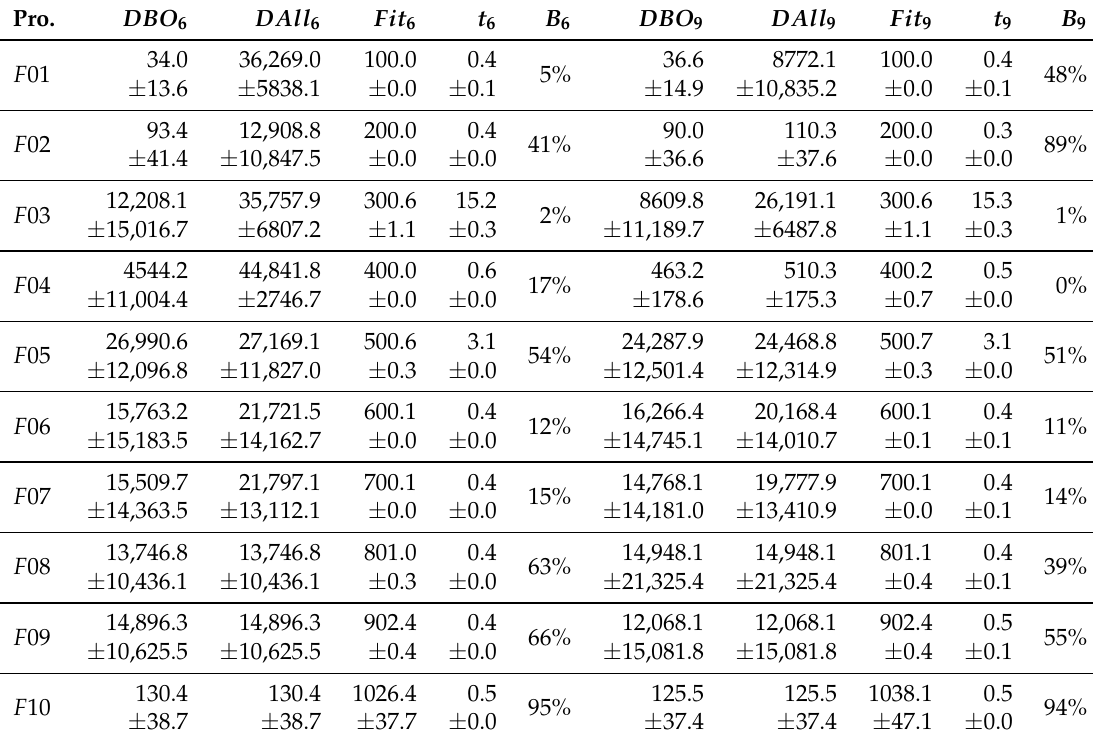
Table 10. jDElscop algorithm on CEC-2015 with LTMA e